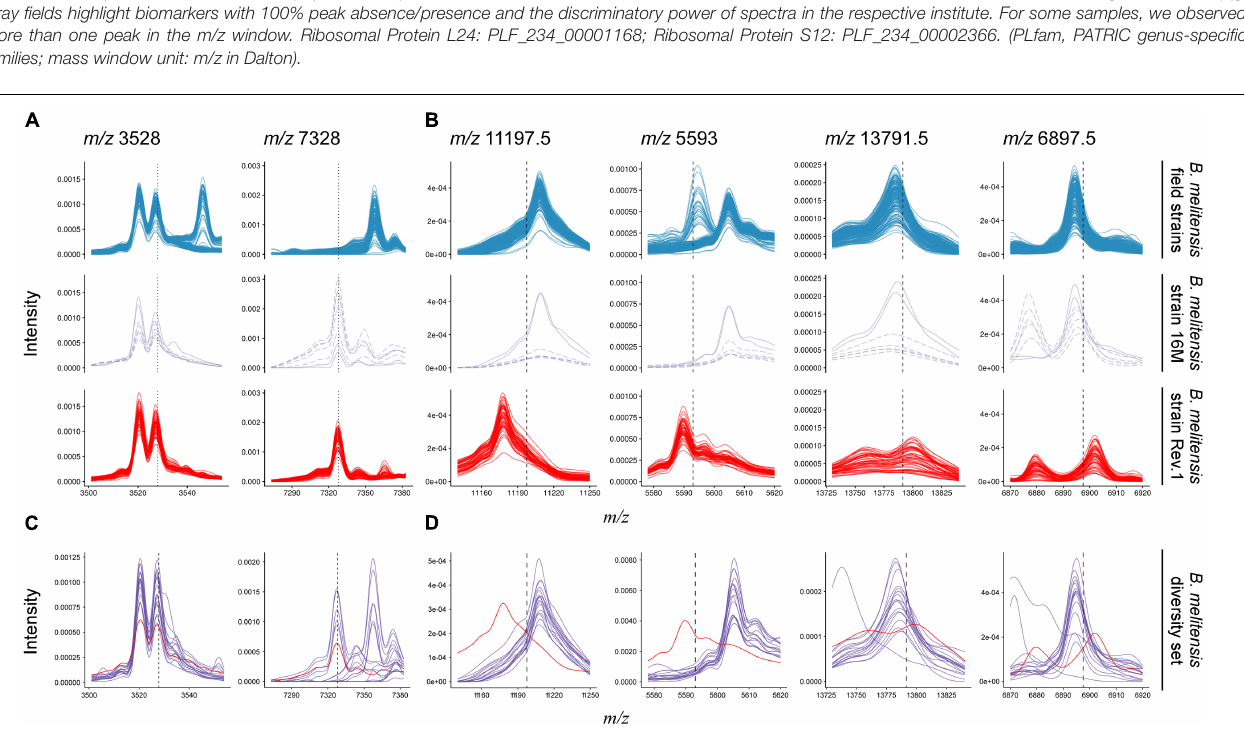
FIGURE 4 | Comparison of B. melitensis field isolate (first row) and Rev.1 (third row) spectra against the type strain B. melitensis 16M (second row) and a diversity set of B. melitensis strains (fourth row) for selected masses. (A) Putative biomarkers (vertical dotted lines) described by Christoforidou et al. (2020). All spectra in this study displayed a peak at m/z 3,528. Most Rev.1 strains as well as the B. melitensis type strain 16M displayed a peak at m/z 7,328. (B) All biomarker decision boundaries (vertical dashed lines) in this study demarcate B. melitensis Rev.1 from B. melitensis 16M and field isolates. (C,D) Spectra from a diversity set of B. melitensis MVLA8 genotypes (purple) are plotted against a group spectrum of B. melitensis Rev.1 samples (red). For clarity, only spectra acquired at the BfR are